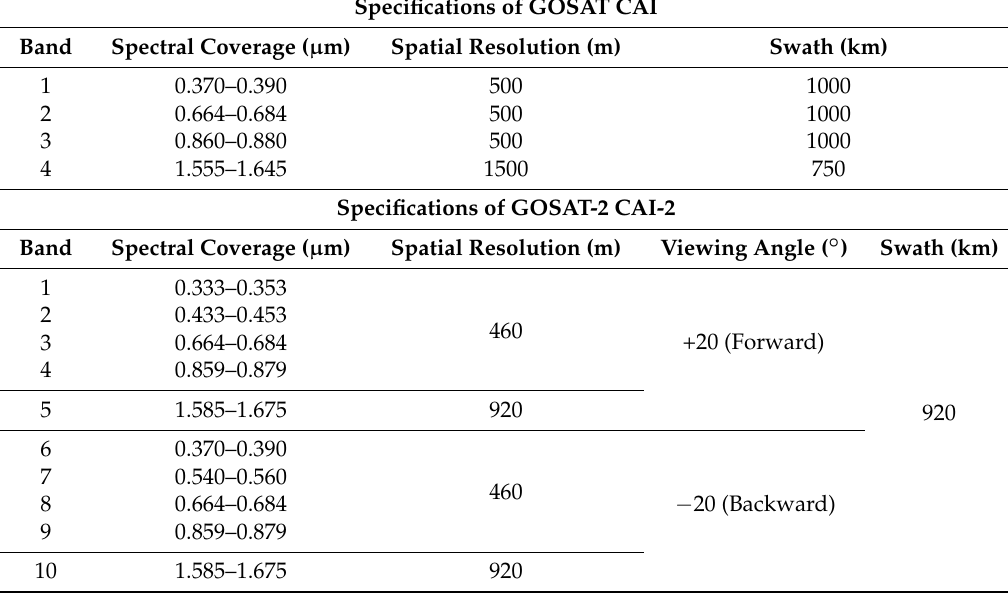
Table 1. Specifications of Greenhouse gases Observing SATellite (GOSAT) Cloud and Aerosol Imager (CAI) and GOSAT-2